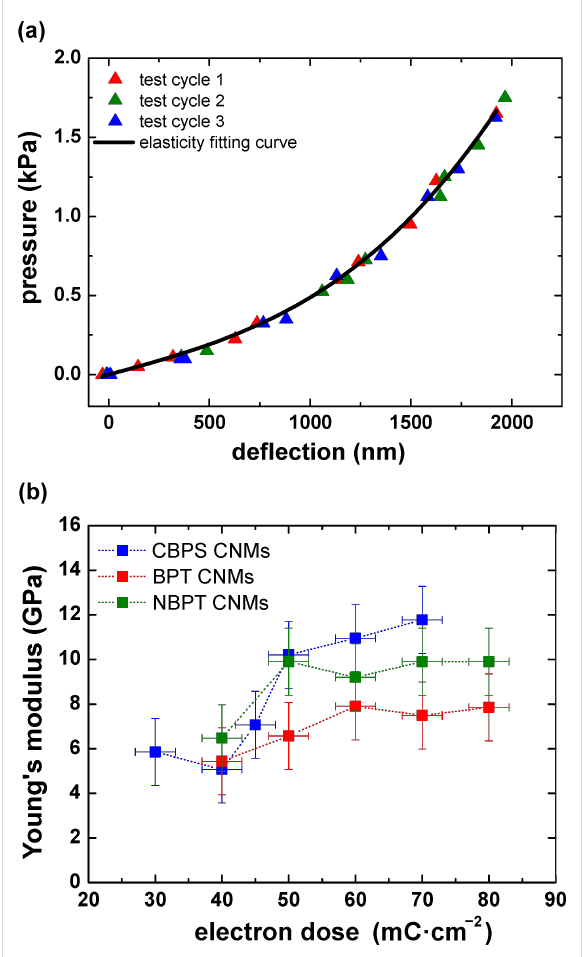
Figure 3: (a) Pressure–deflection relationship of an NBPT CNM with three successive loading and unloading cycles, and the corresponding elasticity fitting curve; (b) Young’s modulus for CBPS, NBPT and BPT CNMs as a function of electron irradiation